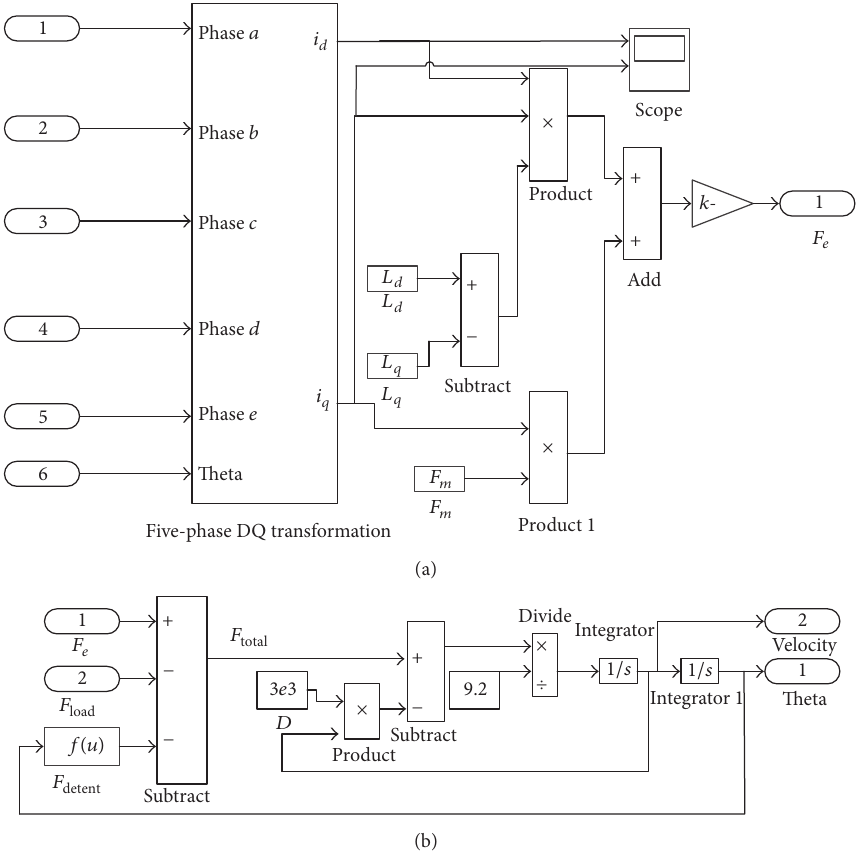
Figure 8: Subsystem of the proposed model: (a) current balance subsystem, (b) mechanical balance subsystem.